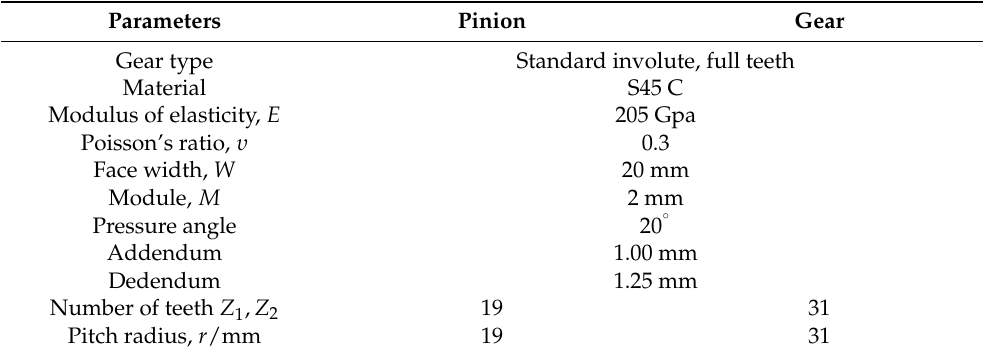
Table 1. Parameters of the gear